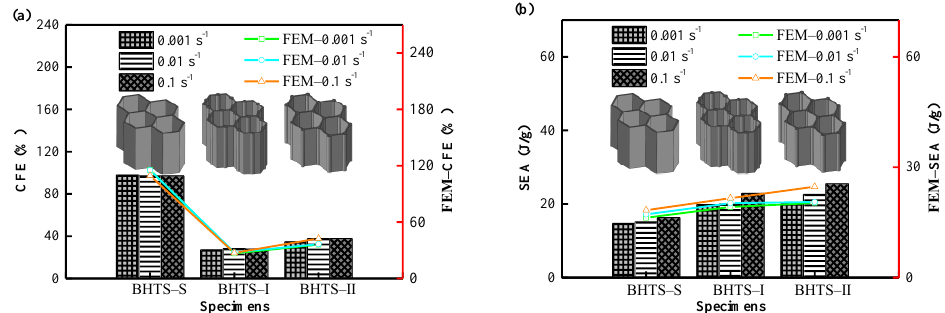
Figure 14. EA assessment indexes of BHTSs at each strain rate: ( a ) average CFE values of test and FEM; ( b ) average SEA values of test and FEM.